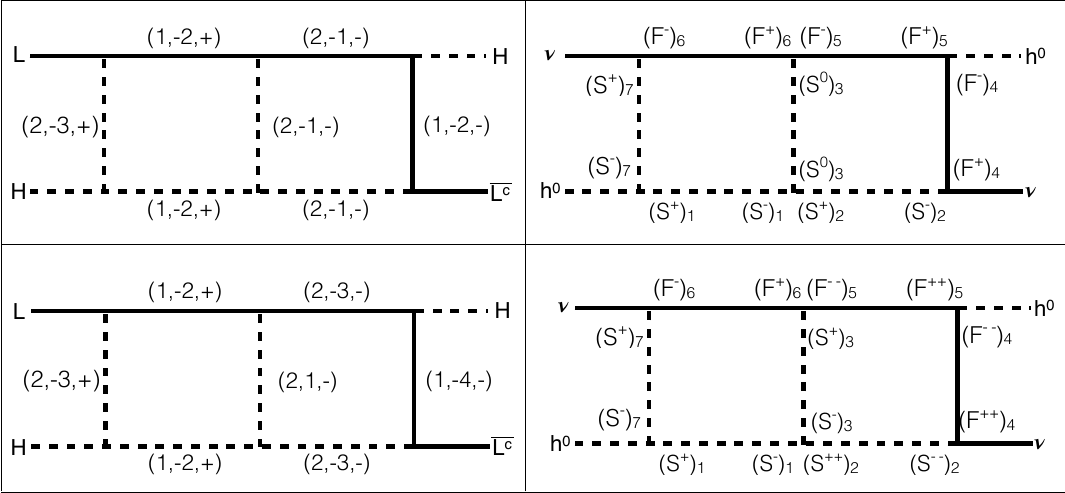
Figure 7. Two models for two-loop diagram of Class 1.d: on the left-hand side we present the two- loop (cid:12)lled with the generic particles ( Y = (cid:0) 1 upper panel, Y = 1 lower panel) while on right-hand side we specify in terms of their